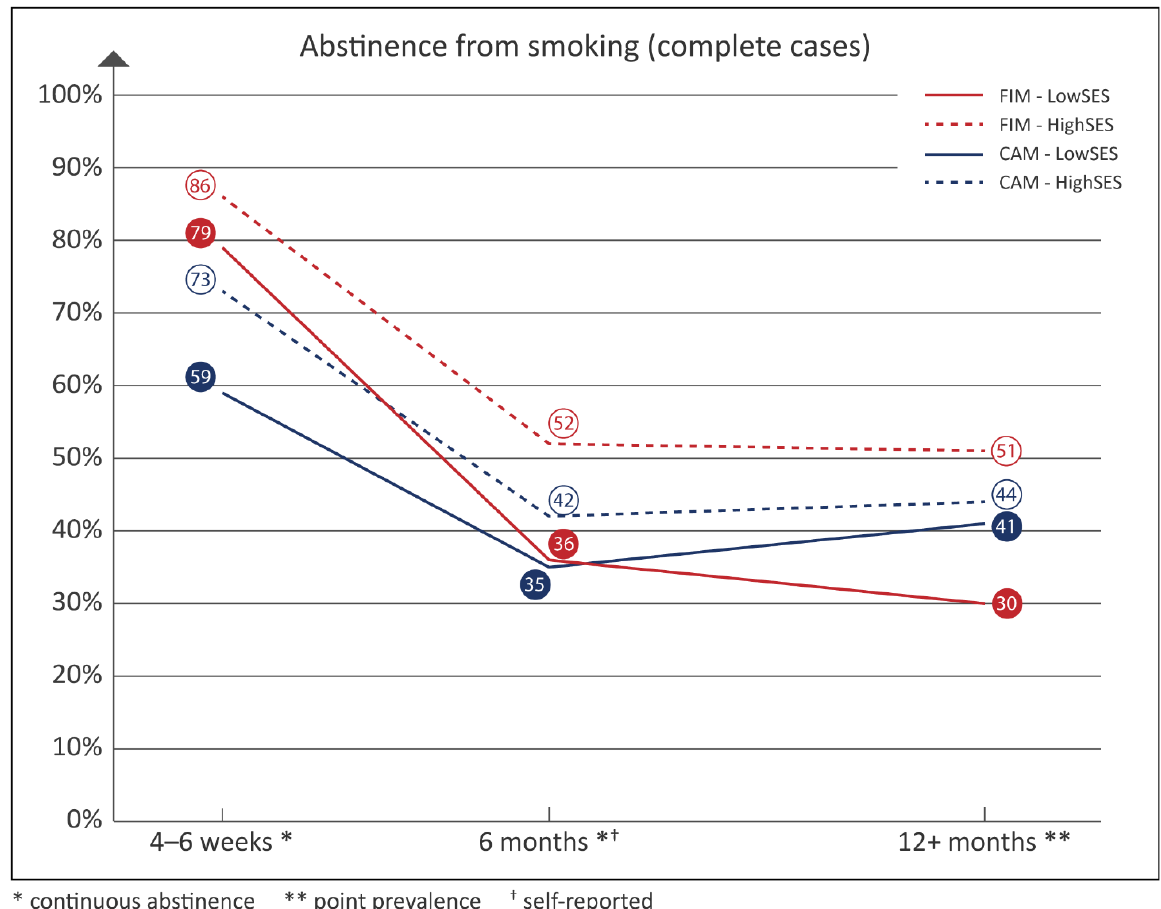
Figure A2. Abstinence rates from smoking in the “Richer without smoking” study, based on a complete case approach; Denmark, 2018. Validated abstinence rates at the end of the intervention (4–6 weeks), after 12+ months, and self-reported abstinence rates after 6 months. FIM: financial in-centive municipality, CAM: campaign municipality, SES: socioeconomic status.